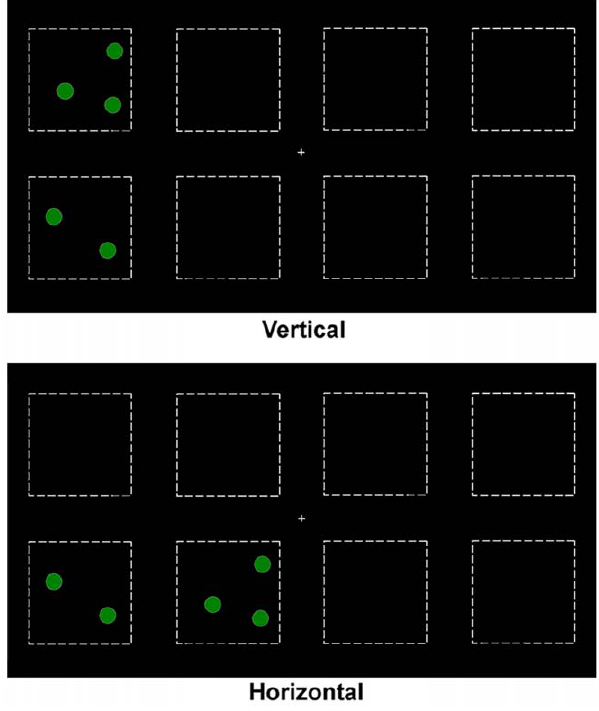
Figure 3. Samples of displays used in Experiment 2. In the vertical condition, the dots appeared in two vertically aligned quadrants within a single hemifield. In the horizontal condition, the dots appeared in two horizontally symmetrical quadrants within a single hemifield. Note that dotted lines that delimitate the quadrants are shown for illustration purpose only. The quadrants were invisible in the experiment.